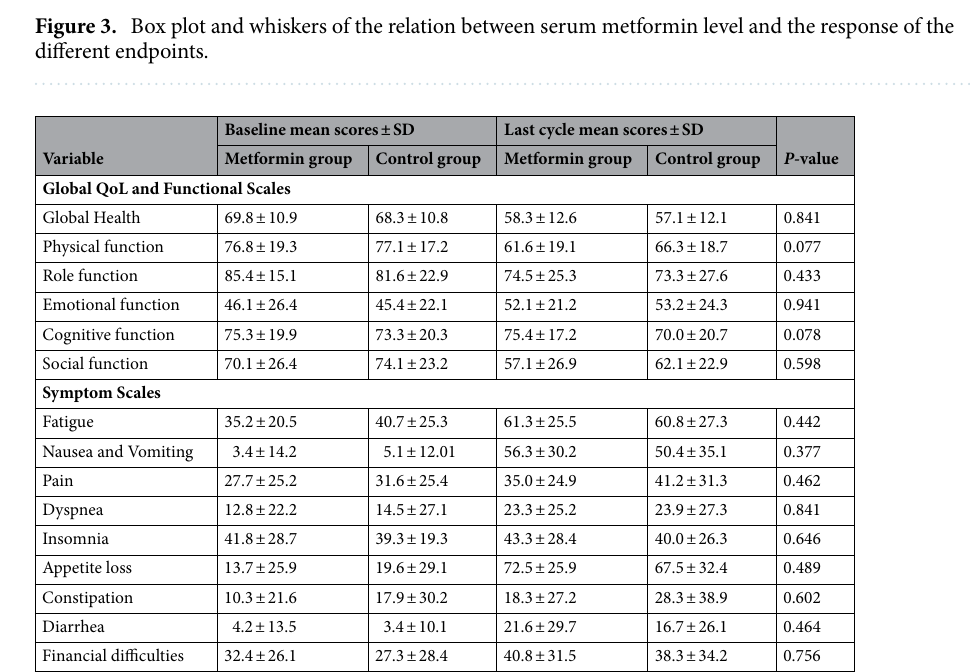
Table 5. Comparison of the mean scores of EORTC QLQ-C30 global QoL, functional, and symptoms scales between the metformin group and the control group at baseline and last chemotherapy cycle. QoL quality of life, EORTC QLQ European Organization for Research and Treatment of cancer quality of life questionnaire, SD standard deviation, P -value: the variance from baseline between the two groups using ANCOVA test.